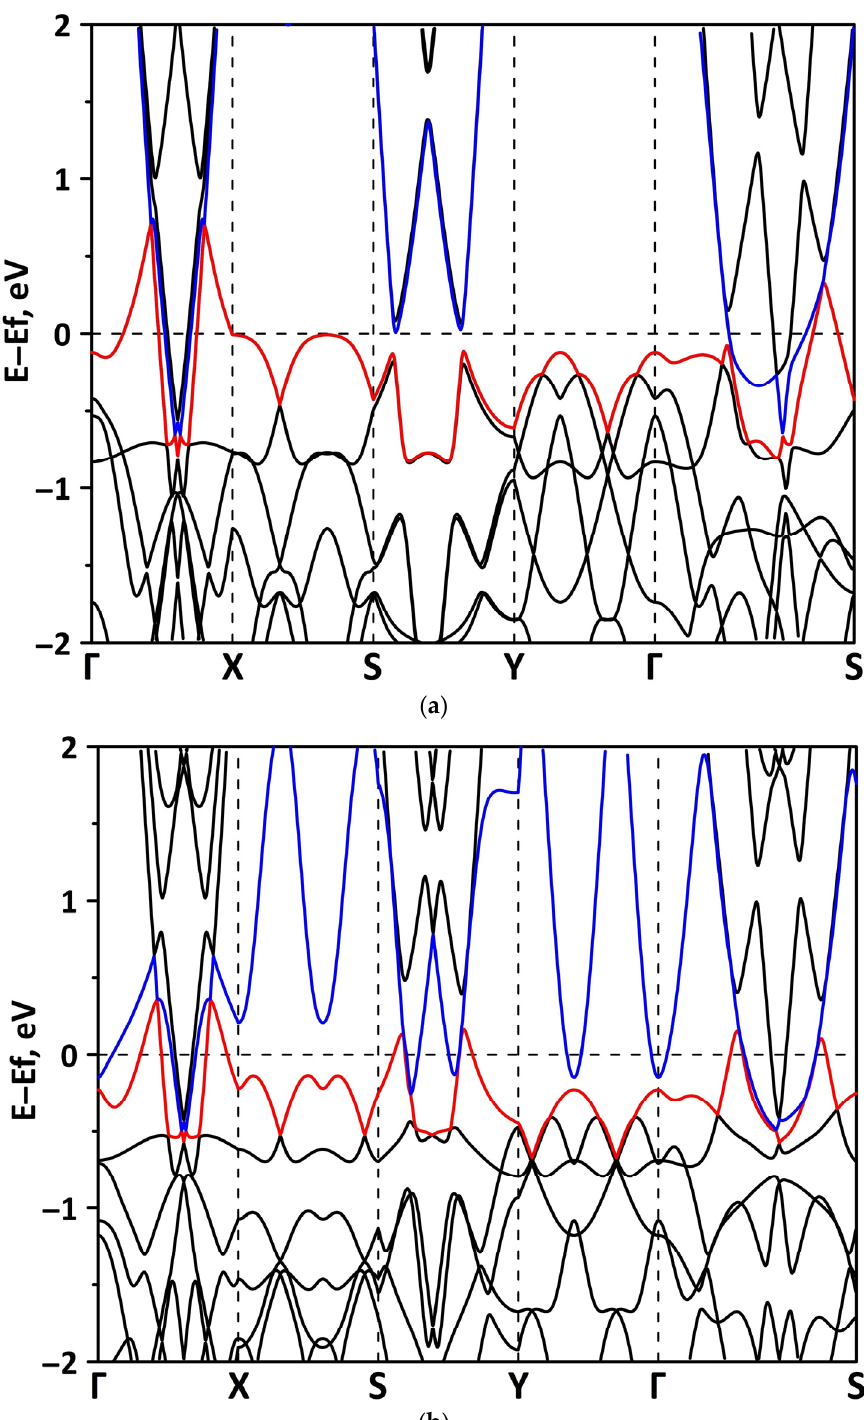
Figure 13. Fragments of the band diagrams near the Fermi level (shifted to 0 eV) of borophene/ZnO heterostructure under uniaxial stretching by 1% ( a ) and 14% ( b ). The VBM is highlighted in red and the CBM is highlighted in blue.